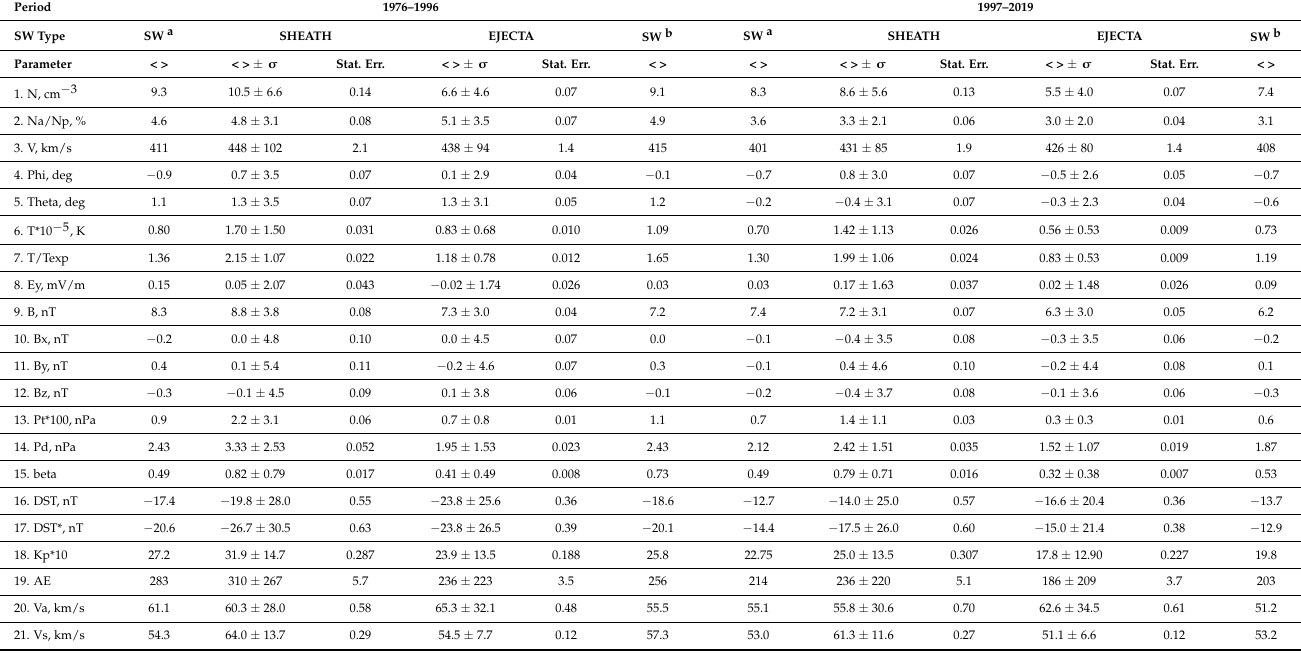
Table 4. Average parameters for sequence SW/SHEATH/EJECTA/SW (Figure